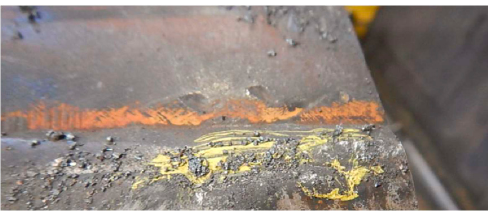
Figure 6. Spatter produced by the use of inadequate wire feed rate. 5.